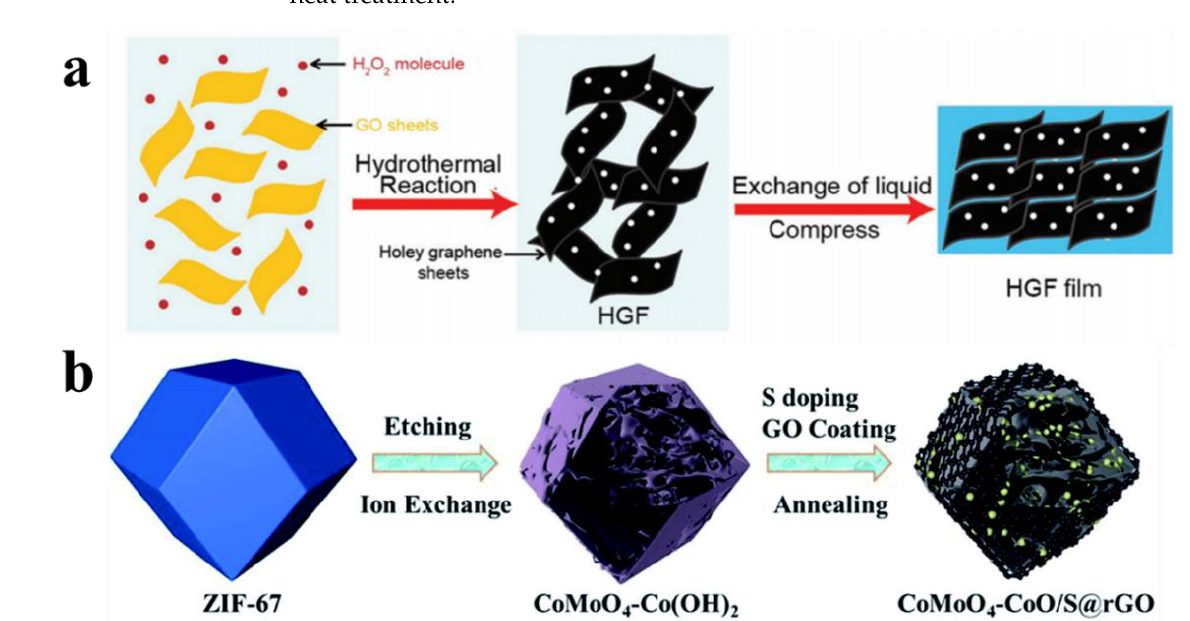
Figure 2. ( a ) Scheme of the synthetic process of HGFs and HGF films. Reprinted with permission from Ref. [29]. Copyright 2021 American Association for the Advanced Functional Materials . ( b )